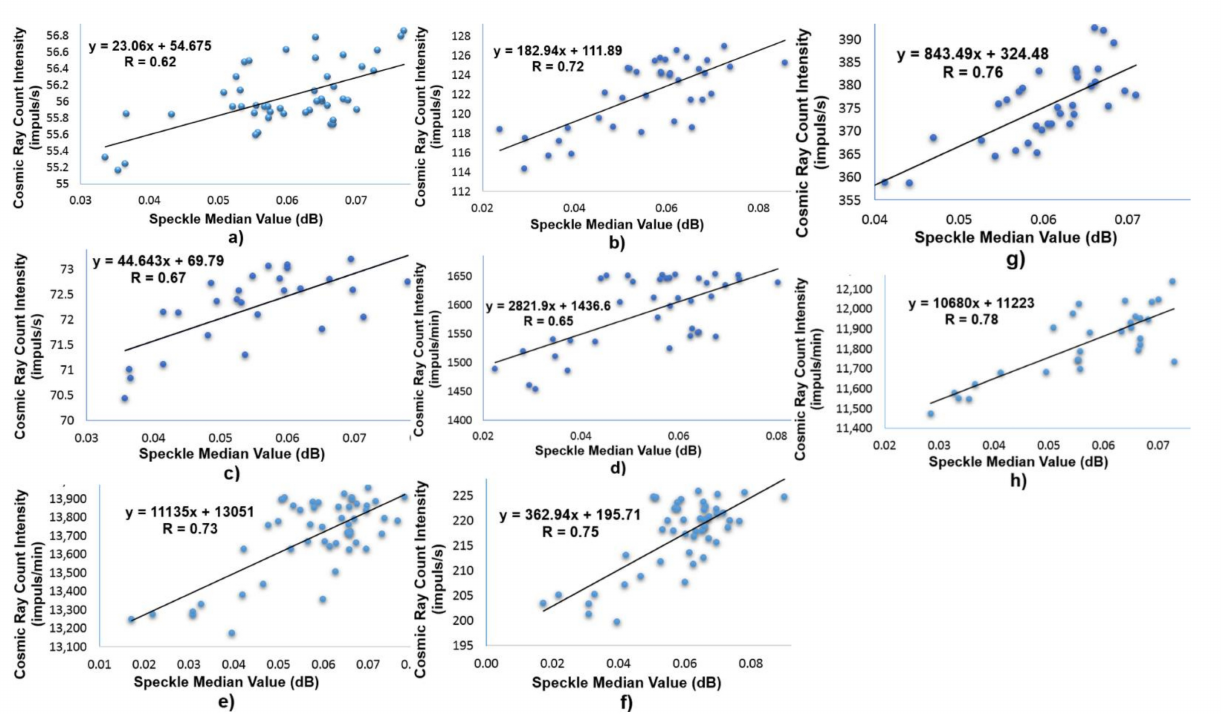
Figure 5. Variation of monthly speckle median and cosmic ray number intensity; ( a ) Athens (Greece) ( b ) Baksan (Russia). ( c ) Castilla–La Mancha (Spain) ( d ) Lom-; nicky-stit (Slovakia) ( e ) Mexico City; (Mexico) ( f ) Nain (Canada) ( g ) NM64; Jungfraujoch (Switzerland) ( h ) Tsumeb